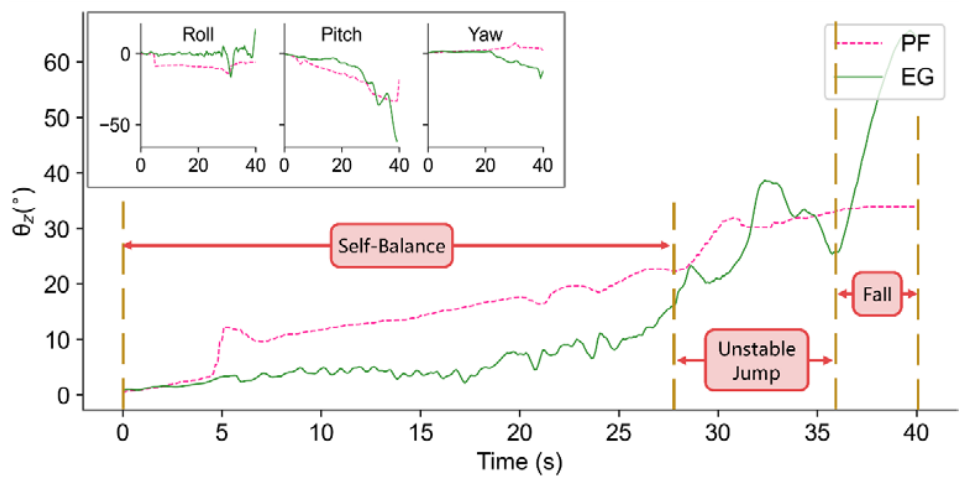
Figure 12. Three stages in the balance process when the platform tilts at the velocity of 1 ◦ /s. 4.2. Real-World Experiment Results and Analysis